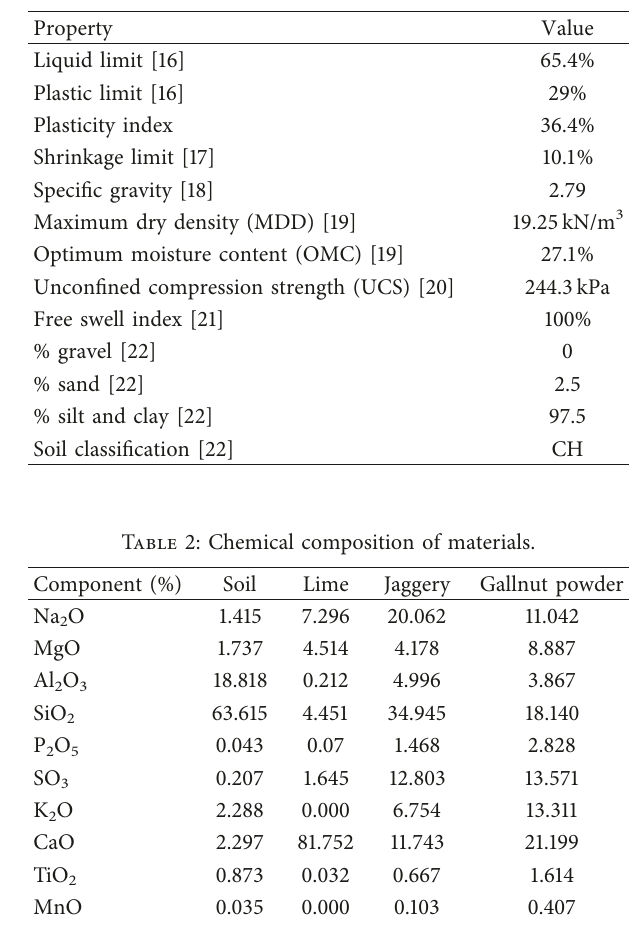
Table 1: Geotechnical properties of the soil.